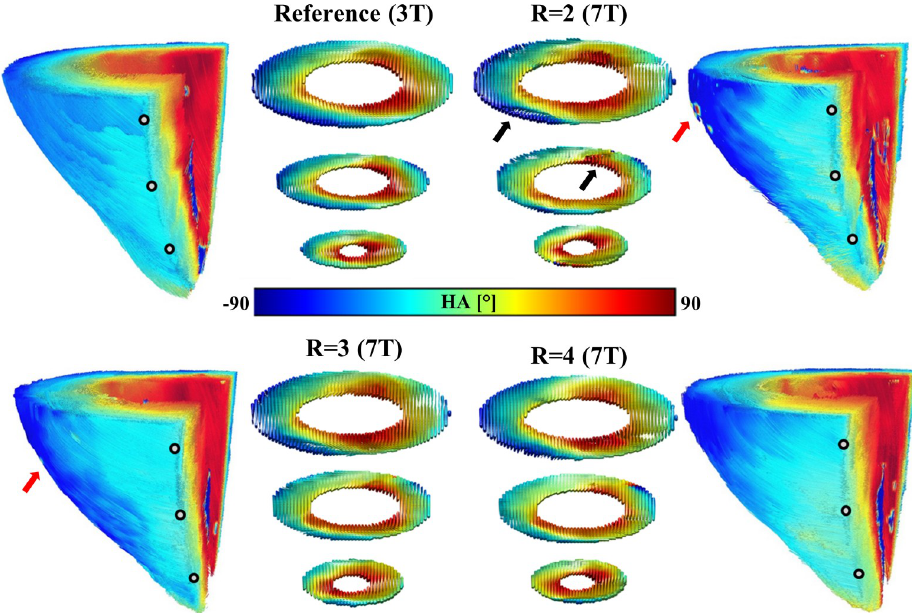
Fig 7. Tractography and helix angle comparison between the 3T reference and GRAPPA accelerated scans at 7 T. Examples of left ventricle tractography from the same heart are displayed for the 3T reference and GRAPPA accelerated scans at 7 T showing differences in resulting tractography and helix angle values. Grey points indicate the position of selected apical, mid-cavity and basal slices. The diffusion tensor within the myocardium of the left ventricle in these slices is visualized as a superquadric glyph. Areas with glyph variation and underlying changes in the diffusion tensor are indicated by a black arrow and areas of helix angle variation in the epicardium with a red